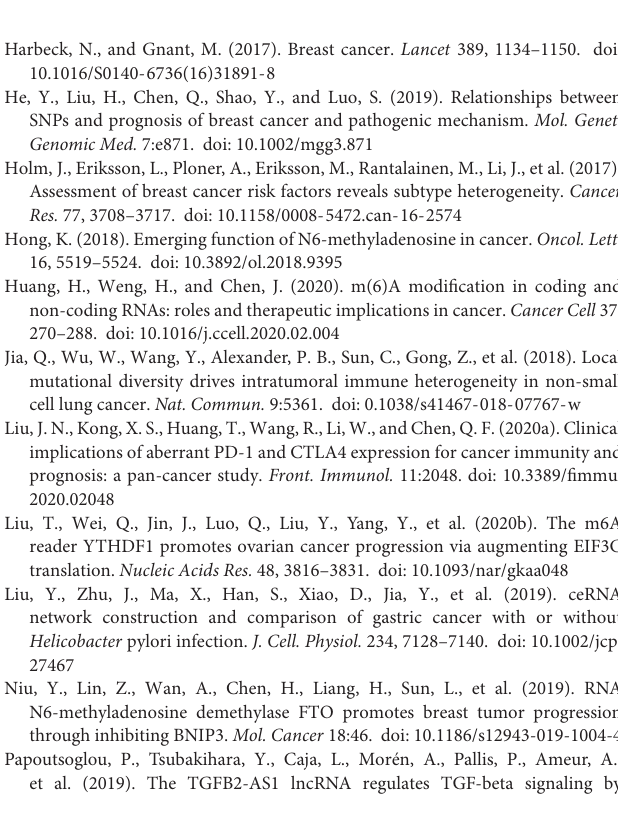
Supplementary Figure 1 | Effector memory CD8 T cell, memory B cell, type 1 T helper cell, type 2 T helper cell, eosinophil, mast cell, natural killer cell, natural killer T cell, plasmacytoid dendritic cell, and CD56dim natural killer cell in two risk groups. Supplementary Figure 2 | (A) Kaplan–Meier curves of OS for BRCA patients with high-risk scores based on the chemotherapy. (B) Kaplan–Meier curves of OS for BRCA patients with low-risk scores based on the chemotherapy. (C) Distribution of risk scores, survival status for BRCA patients in the chemotherapy subgroup. (D) ROC curve for patients with 3. 5-, 5-, and 7.5-year survival times in the chemotherapy subgroup. Supplementary Figure 3 | (A) Differences of IC 50 of drugs (nelarabine, ZM-336372, cyclophosphamide, and dexamethasone Decadron) between low and high expression of ZNF197-AS1 groups. (B) Correlations of IC50 of drugs (nelarabine, ZM-336372, cyclophosphamide, and dexamethasone Decadron) with various expressions of ZNF197-AS1. Supplementary Figure 4 | Kaplan–Meier curves showed the stratification analysis of the m6A-LPS. The m6A-LPS retained its prognostic value in multiple subgroups of BRCA patients (including patients aged ≤ 65 or > 65 years, female or male, stage I and II or stage III and IV, T1 and 2 or T3 and 4, M0 or ≥ M1, N0 or N1–3 and PAM50 molecular subtypes). Supplementary Figure 5 | (A) Kaplan–Meier curve of OS for BRCA patients and ROC curve based on the signature including the protein-coding genes. (B) ROC curve for the 12 lncRNAs of all BRCA patients in TCGA